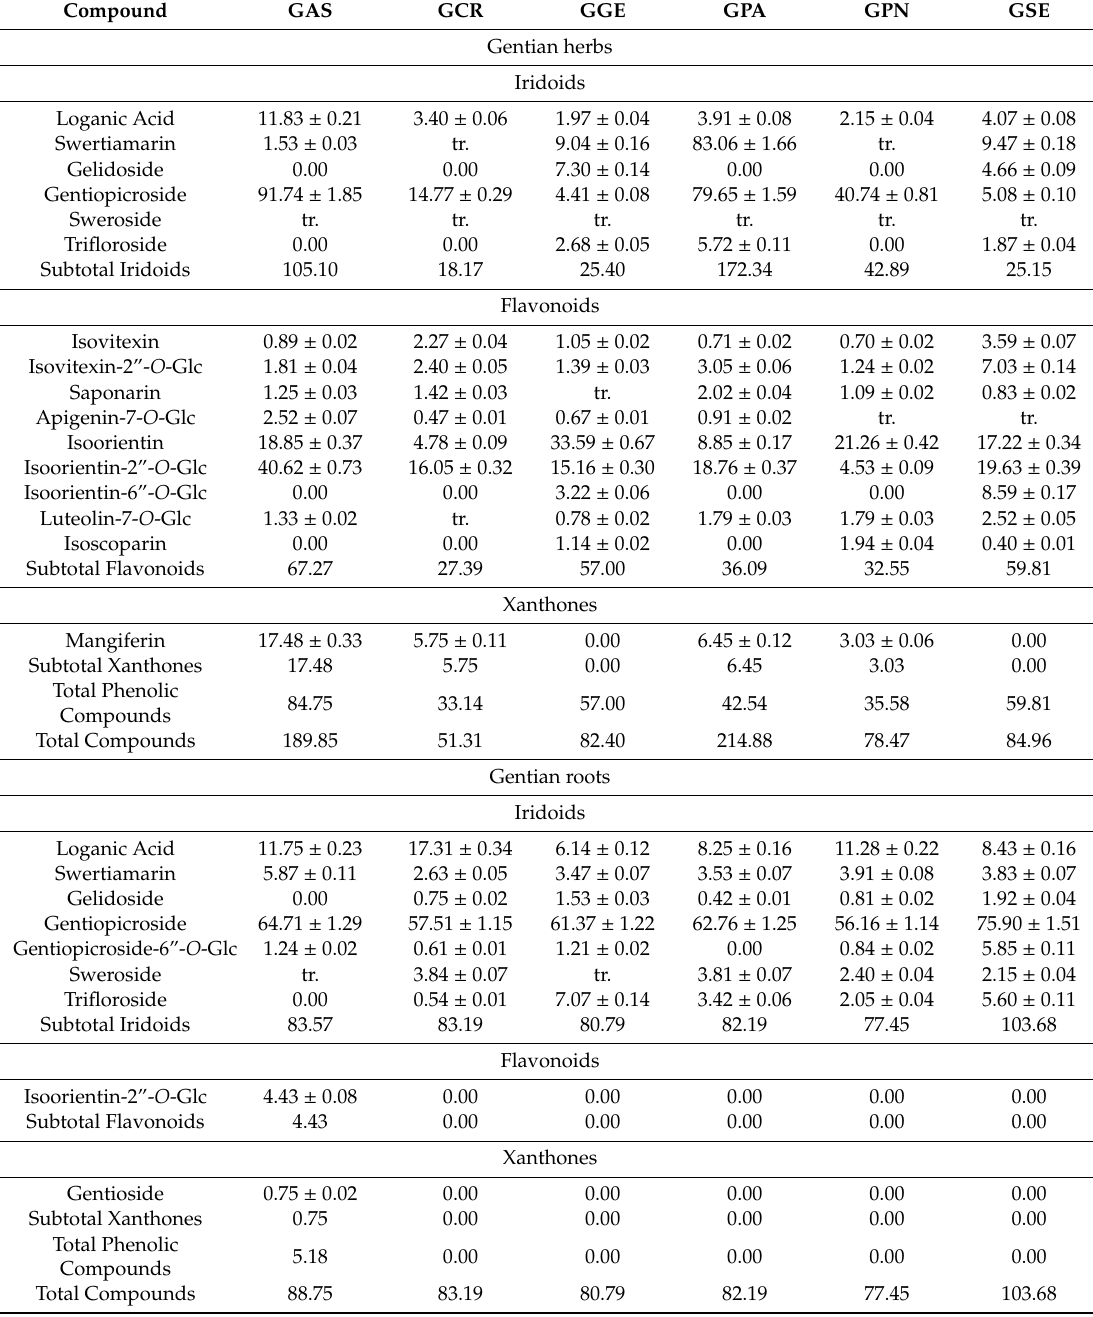
Table 2. Content of selected compounds in gentian herbs and roots a , mg / g of dry plant weight ( ± S.D.).